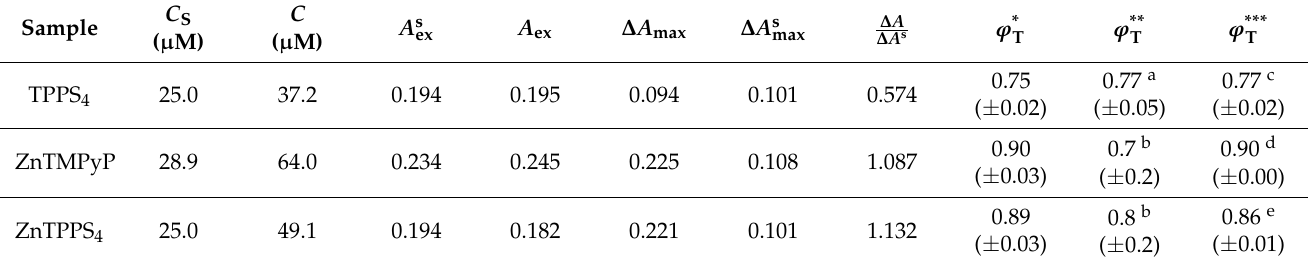
(cid:0) (cid:1) ϕ ∗ , obtained from the kinetic analysis T (cid:0) (cid:1) ϕ ∗∗∗ T